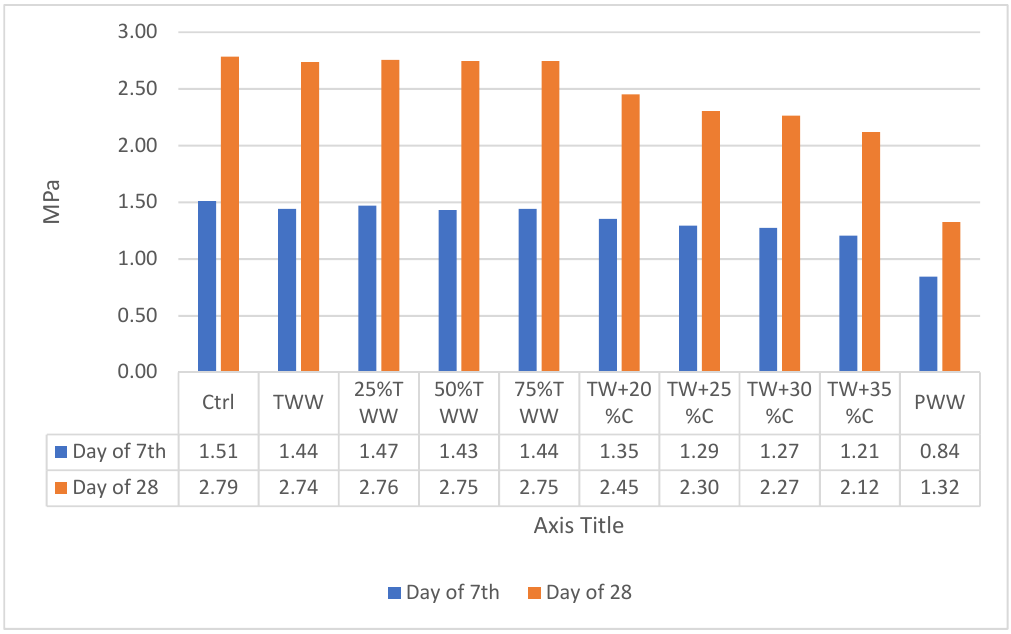
Figure 9. The results of tensile strength cured by treated wastewater.